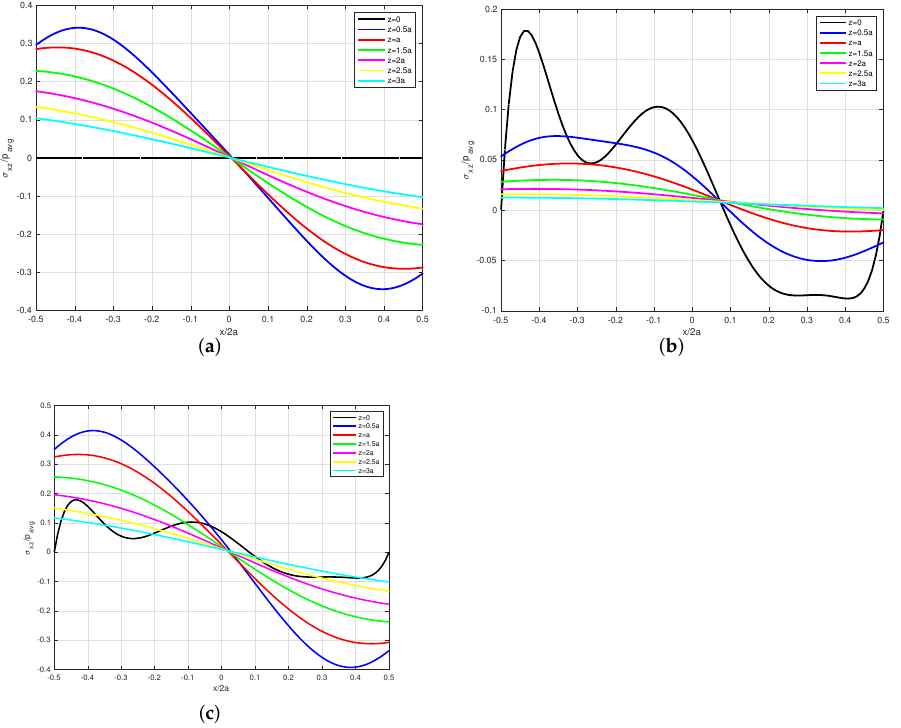
Figure 11. Shearing stress σ xz at various depths due to ( a ) normal component of boundary traction p ( x (cid:48) ) ; ( b ) tangential component of boundary traction q ( x (cid:48) ) ; ( c ) both p ( x (cid:48) ) and q ( x (cid:48) )